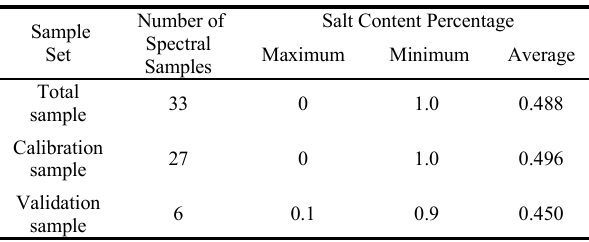
Table 2. Spectral data and salt content statistics of mural